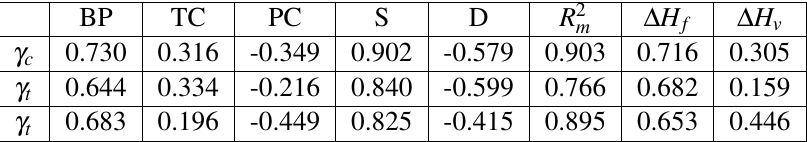
Table 3 Correlation of Domination parameters with physicochemical properties of octane isomers.